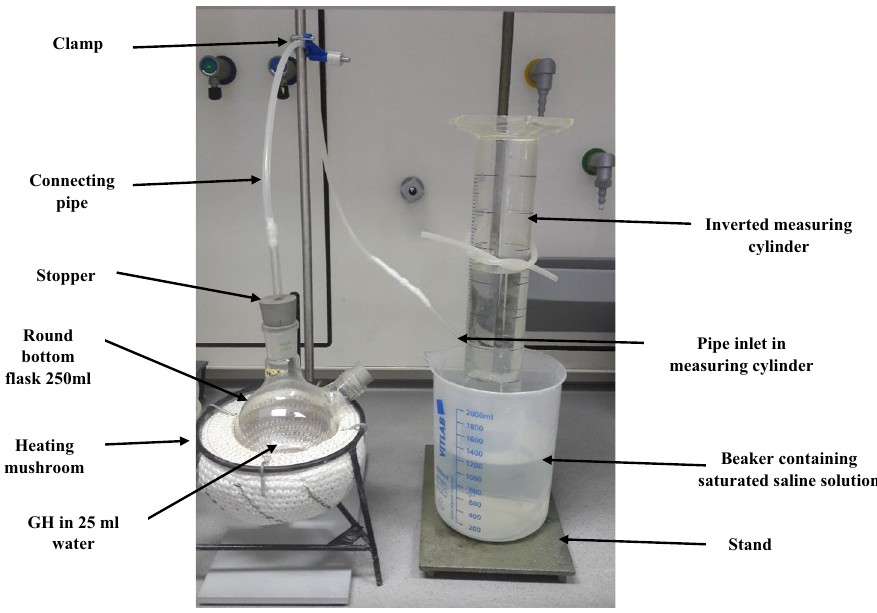
Figure 7. Experimental set up for CO 2 gas release measurement from the GH at 90